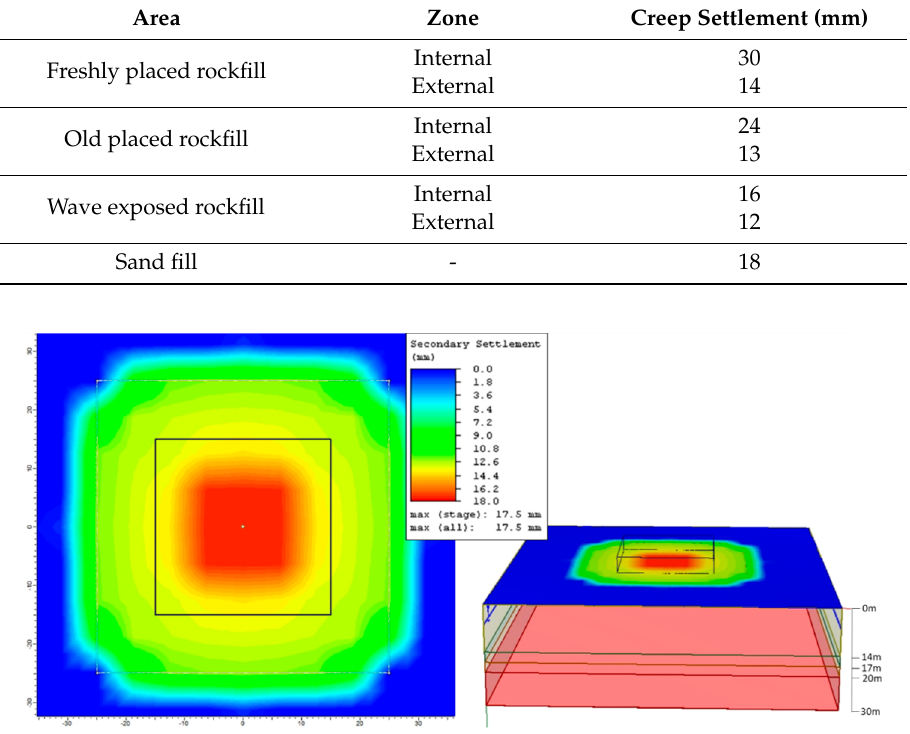
Figure 10. Settlement analysis of sand fill. A 35kPa uniform pressure zone was adopted after removing of the preloading surcharge. The plan view is presented in the left side of the figure. The dot in the center of the plan view indicates the query point on which the settlement was calculated. The 3D model is presented in the right side of the figure. The soil layers and their depths are indicated in the 3D model. Table 6. Summary of Settle 3D creep settlement results over a period of 50 years.